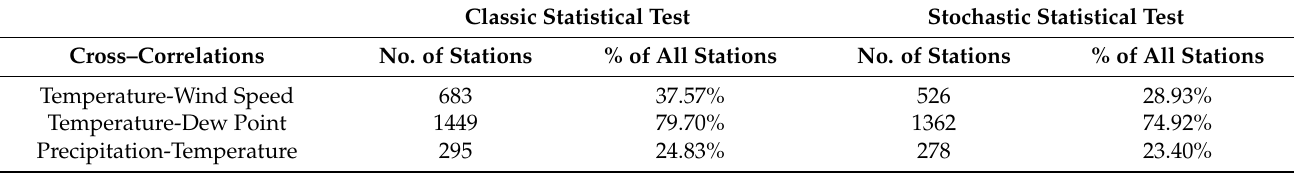
Table 4. A comparison between statistical significance methods, displaying the number of stations with a significant cross–correlation and their percentage out of the total number of stations reviewed in this study. Classic Statistical Test Stochastic Statistical